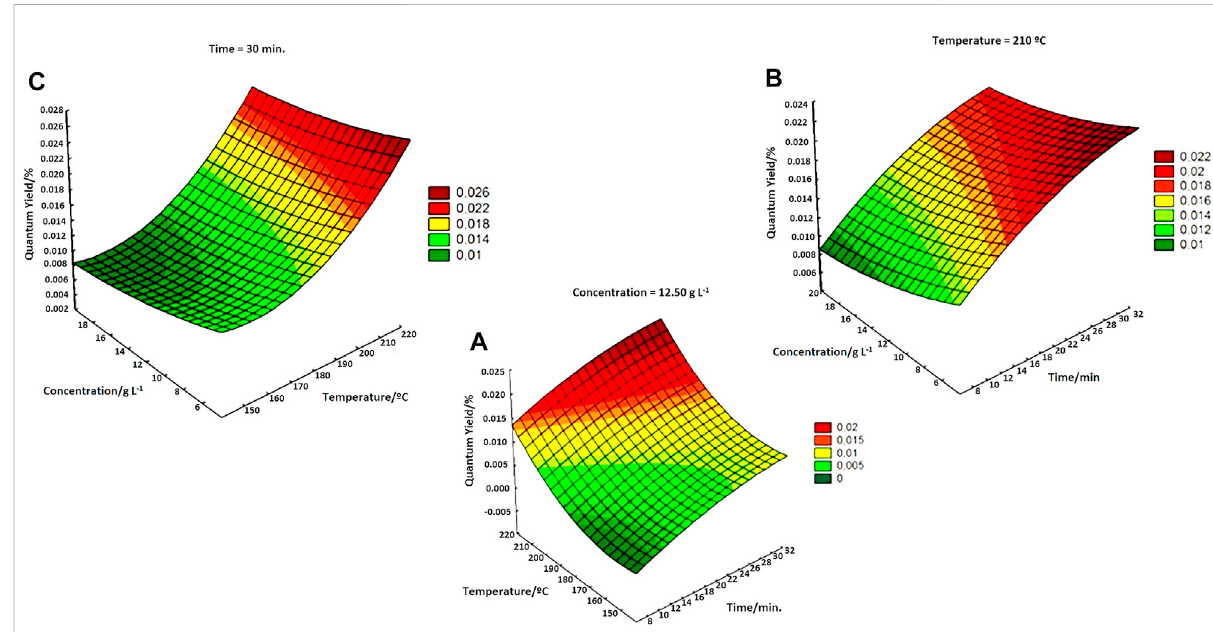
FIGURE 1 (A) Variation in QY at a fi xed concentration of 12.50 g L − 1 as a function of temperature and synthesis time. (B) Variation in QY with a fi xed temperature at 210 ° C and varying concentrations and synthesis times. (C) Variation in QY with a fi xed time of 30 min varying the concentration and synthesis